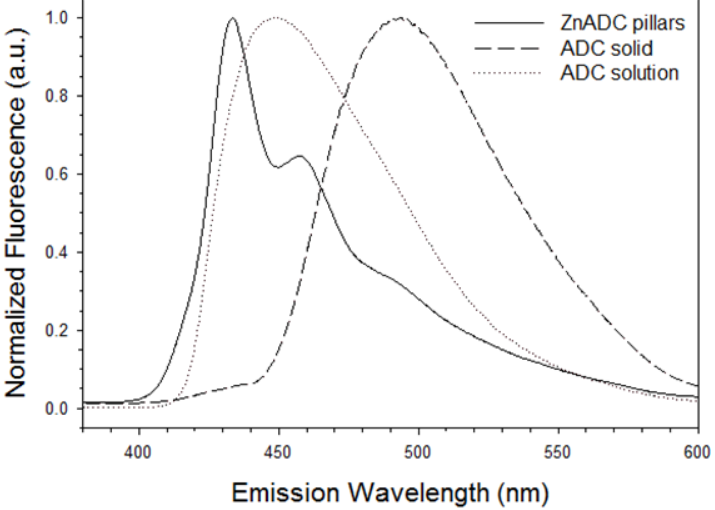
Figure 6. Fluorescence emission spectra of Zn(ADC)·DMSO and 9,10-anthracenedicarboxylic acid using solid-state and solution ( λ ex = 320 nm).